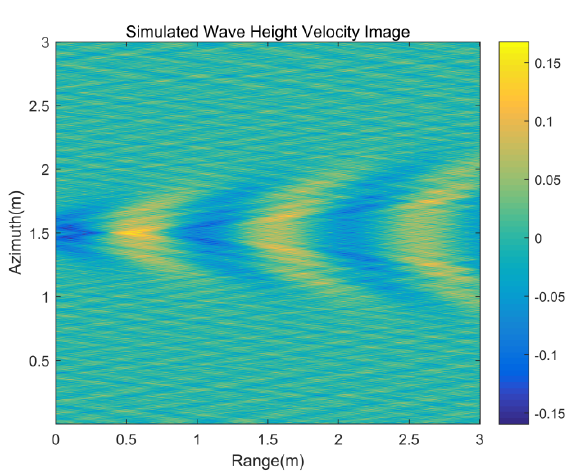
Figure 3. Kelvin wake wave height velocity image.